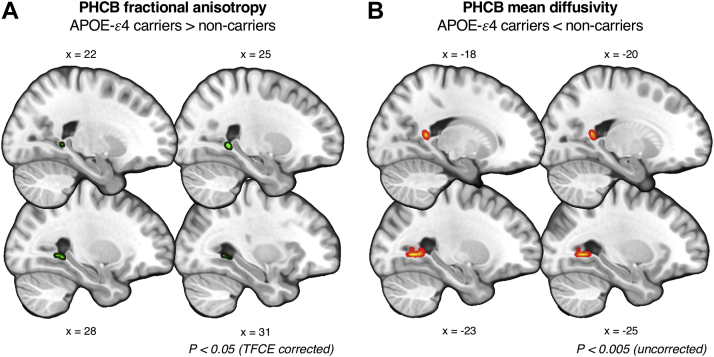
Comparing parahippocampal cingulum bundle (PHCB) microstructure in APOE-ε4 carriers and noncarriers using TBSS. (A) A significant cluster (shown in green) was found showing greater FA in APOE-ε4 carriers versus noncarriers in the posterior PHCB (p < 0.05, TFCE-corrected). (B) A subthreshold cluster (shown in red-yellow) reflecting lower MD in APOE-ε4 carriers versus noncarriers was identified in the posterior PHCB (p < 0.005, uncorrected). For visualization purposes, clusters have been “thickened” using “TBSS fill” in FSL. There were no voxelwise differences for MD that survived stringent correction. Abbreviations: FA, fractional anisotropy; MD, mean diffusivity; PHCB, parahippocampal cingulum bundle; TBSS, tract-based spatial statistics. (For interpretation of the references to color in this figure legend, the reader is referred to the Web version of this article.)